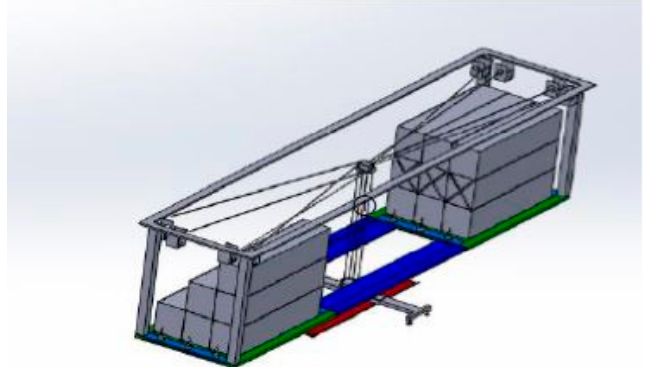
Figure 2. The smart crane: CHAYA. Eight winches have the role of controlling these eight cables. These are controlled and coordinated by a computer. The motion of the platform is controlled by an operator through a six-axis joystick with six DOFs. The operator can handle and manipulate the trunk and any load attached to it over a large volume of work inside the hold.